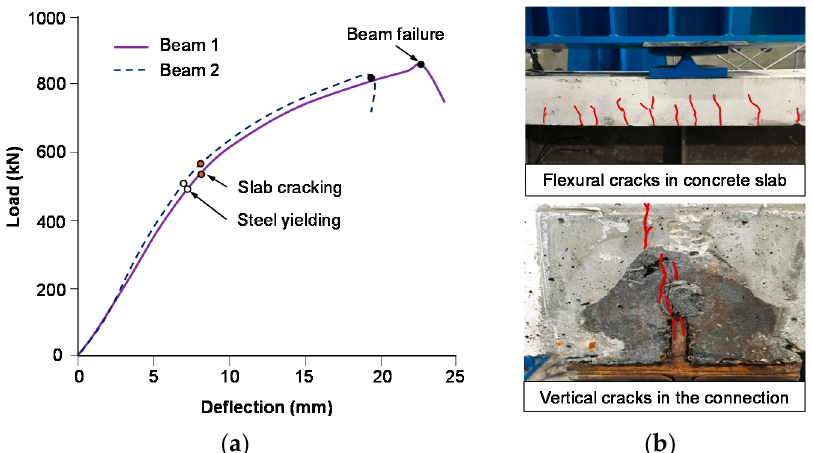
Figure 9. Static testing results of Beam 1 and Beam 2: ( a ) load-deflection curves; ( b ) failure mode.